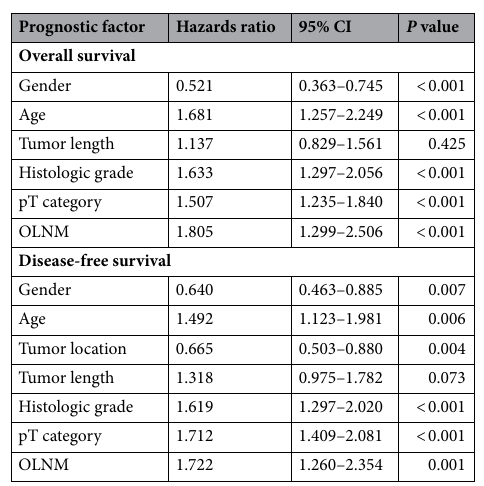
Table 3. Multivariate Cox regression analysis in regard to overall survival and disease-free survival of the 516 patients with pN0 esophageal squamous cell carcinoma. CI confidence interval.